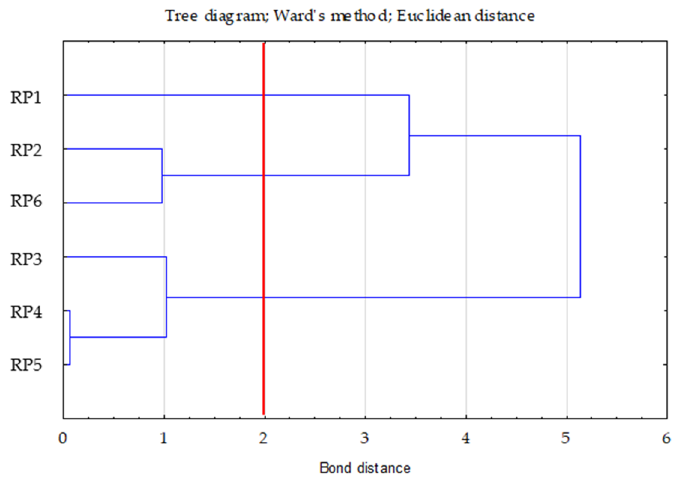
Figure 2. Tree diagram—Ward’s dendogram for TOC, Nt and C/N. All variables significantly differentiate ( p < 0.05) the clusters obtained by the k-means method (Table